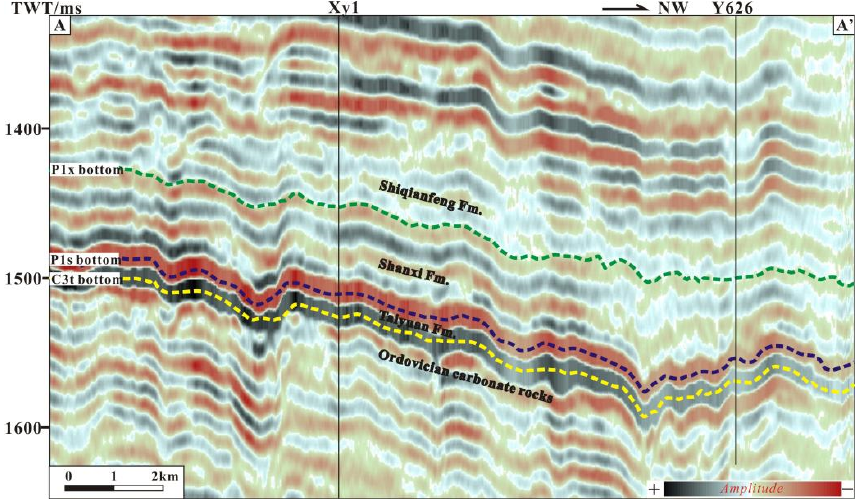
Figure 4. Seismic section across wells Xy1 and Y626 in the NW direction. See Figure 5a for the location. TWT: two-way travel time.